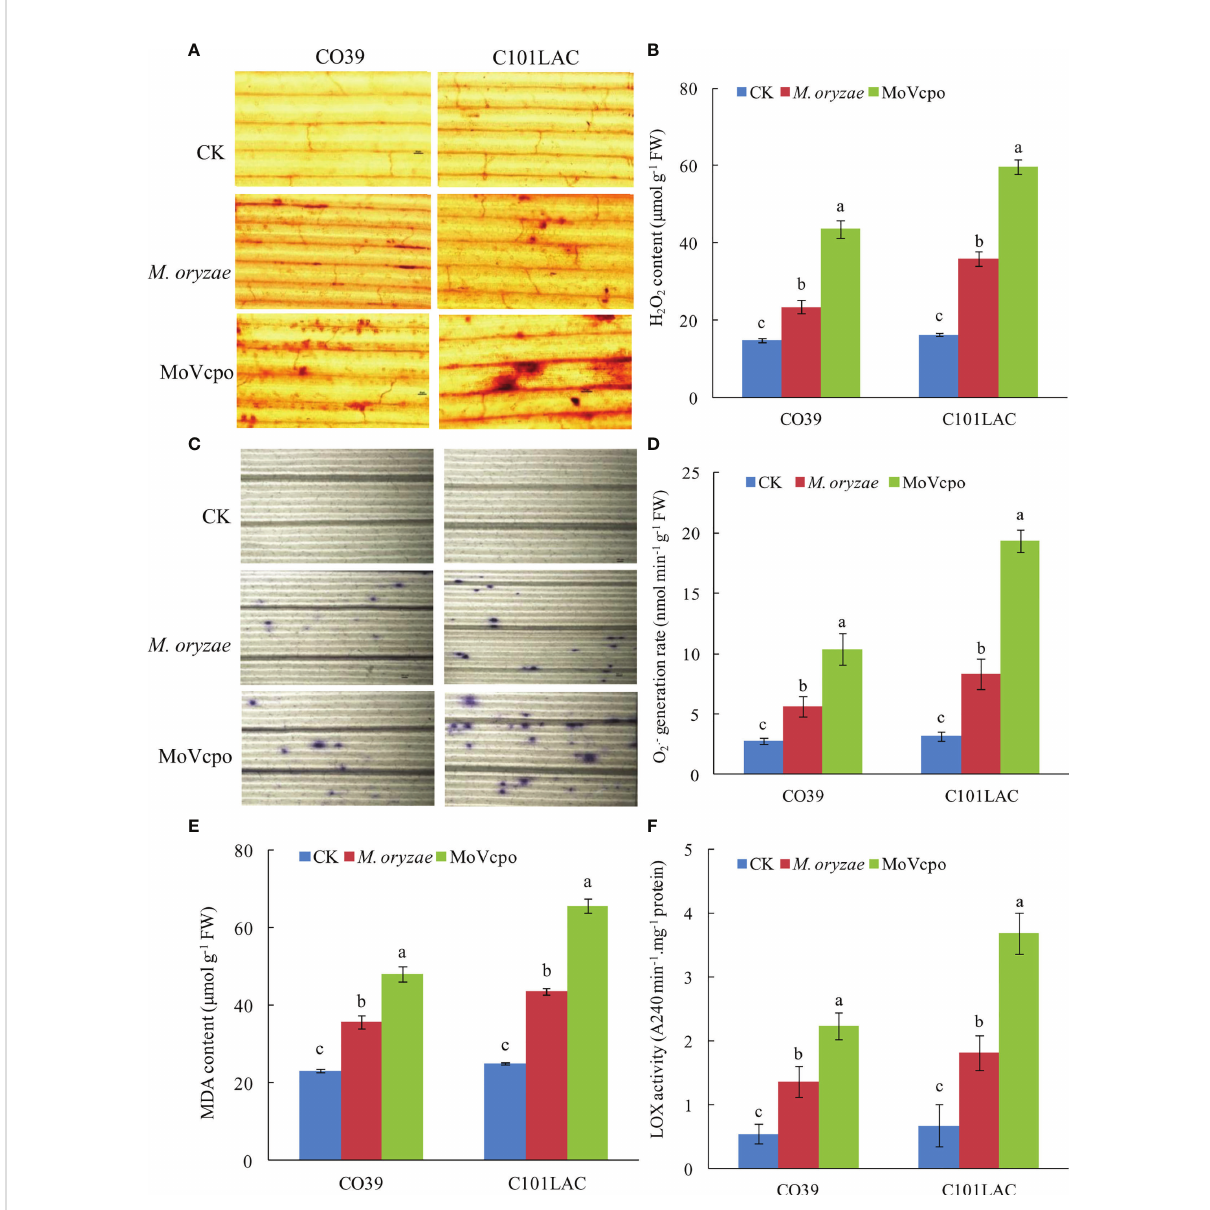
FIGURE 4 ROS accumulation in rice leaves induced by MoVcpo. (A) H 2 O 2 production detected by DAB staining at 24 h after inoculation. (B) Quantitative analysis of H 2 O 2 content in rice leaves. (C) O 2.- production detected by NBT staining at 24 h after inoculation. (D) Quantitative analysis of O 2.- content in rice leaves. (E) MDA contents. (F) LOX activity. Arrowheads indicate the stained spots in rice leaves. Experiments were repeated at least three times. Values are the means from three independent experiments and bars indicate standard deviations. The letters above the bars are signi fi cantly different at 0.01